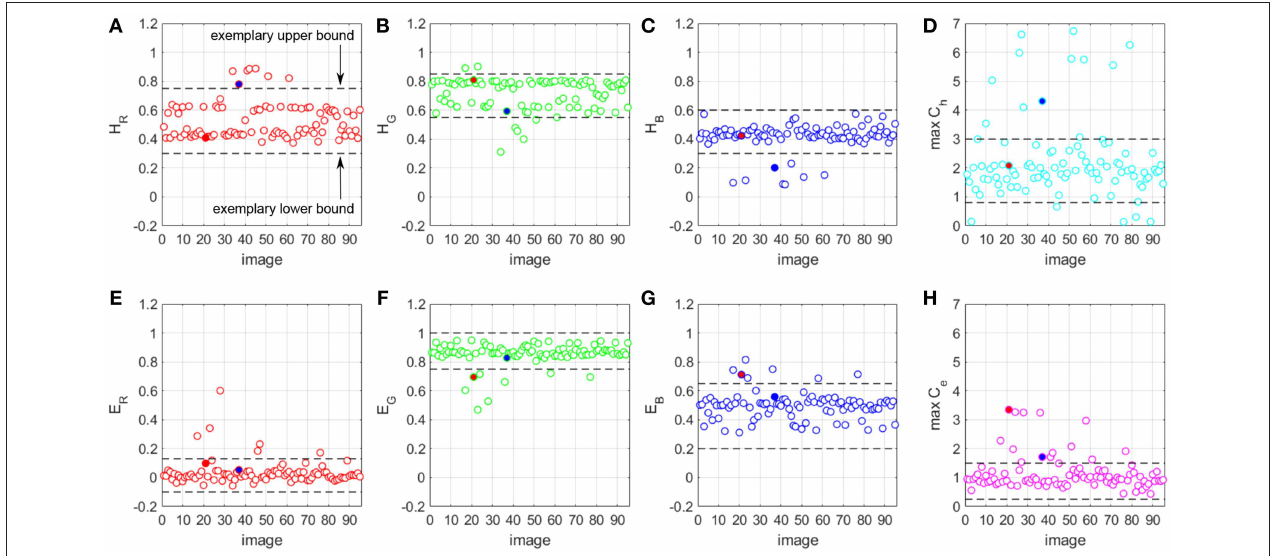
FIGURE 8 | H&E vector components (A–C,E–G) and maximum C h and C e values (D,H) for a prostate biopsy WSI